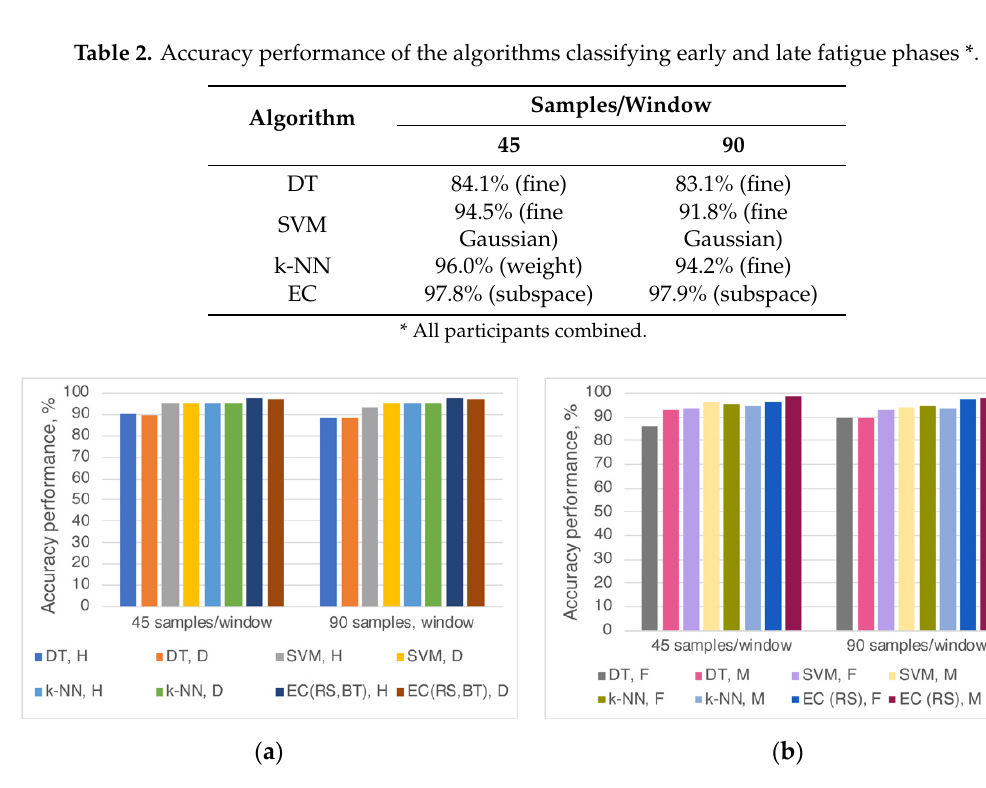
Figure 3. Accuracy performances of the algorithms for early and late fatigue classification when participants were divided according to ( a ) health condition (H—healthy; D—diabetes) or ( b ) gender (F—female; M—male).